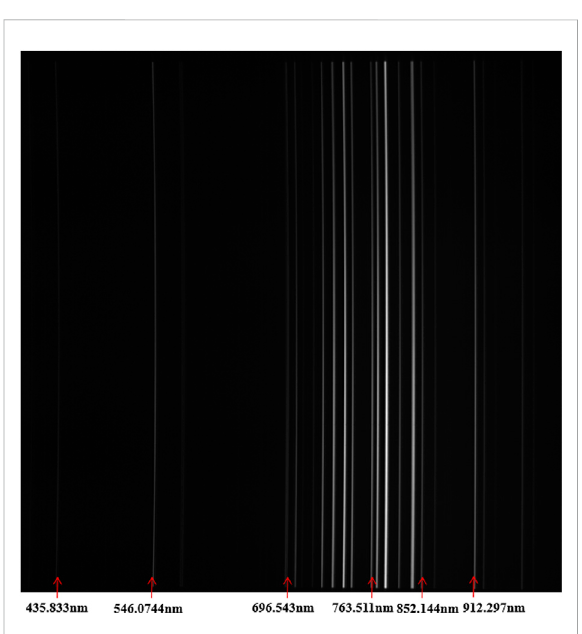
FIGURE 6 Raw data of the mercury lamp obtained by the